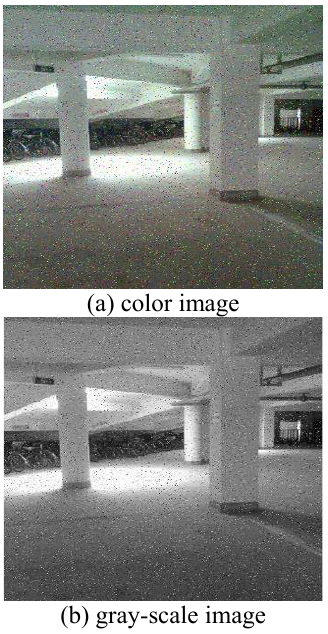
Figure 2 color image and gray-scale image